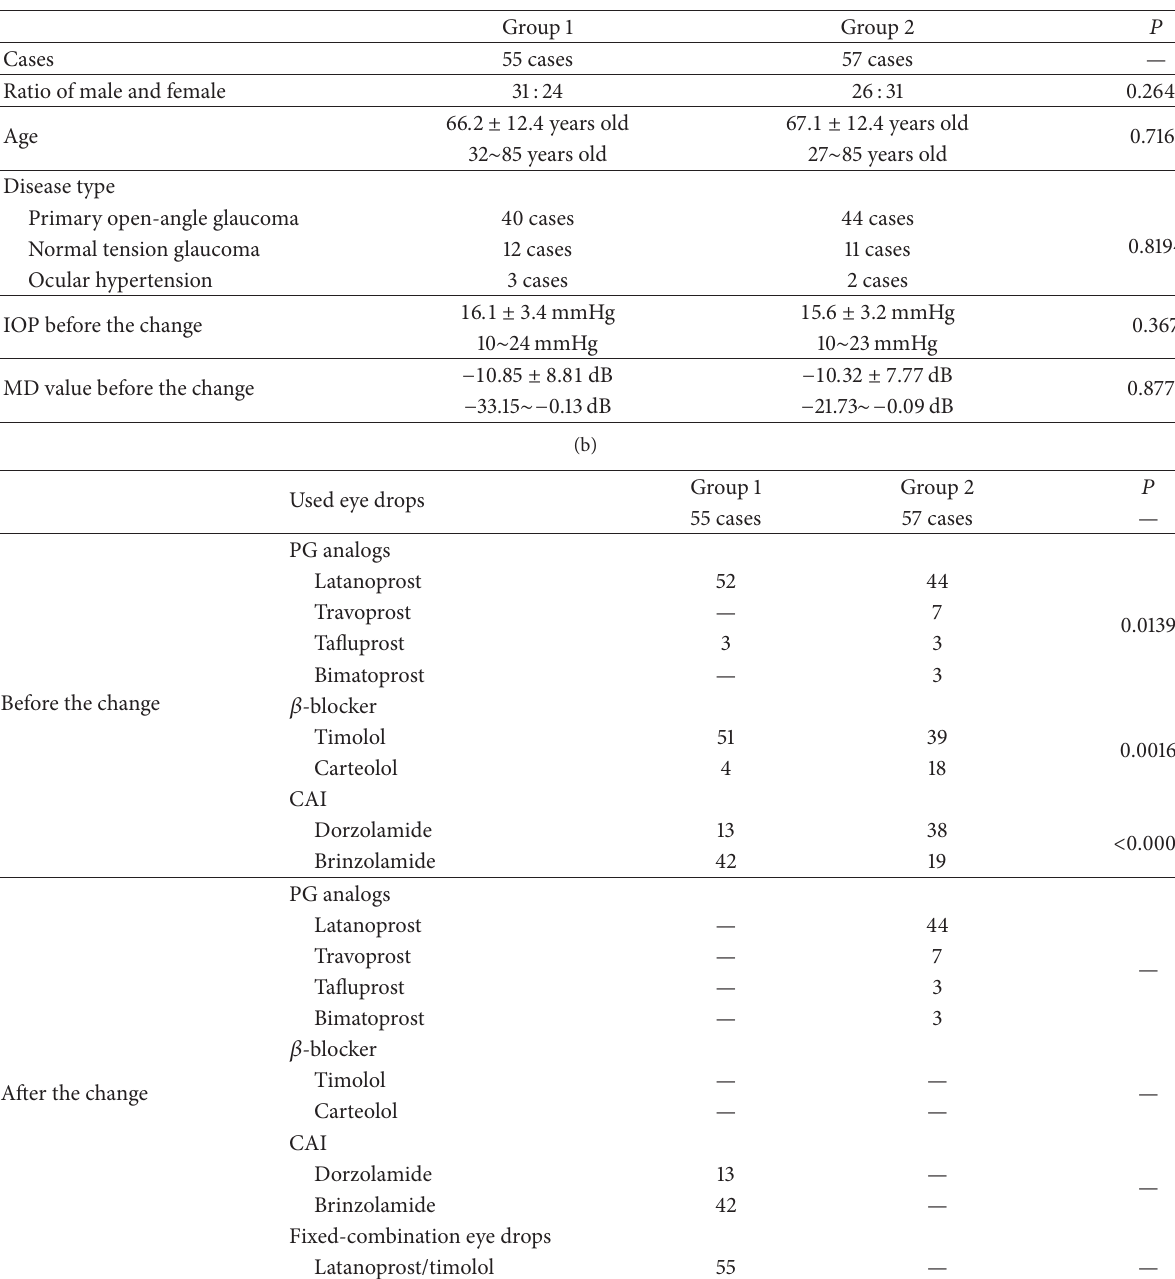
Table 1: Patient